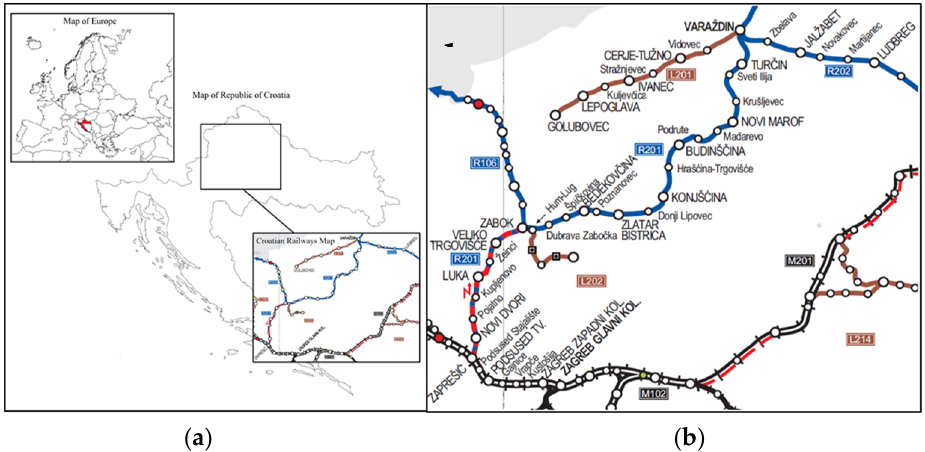
Figure 1. ( a ) The geographic location of the study area; ( b ) A more detailed view of the studied railways (Croatian Railways Map: brown lines represent local railway, blue lines represent regional railway, bold black lines represent international railway [62]).